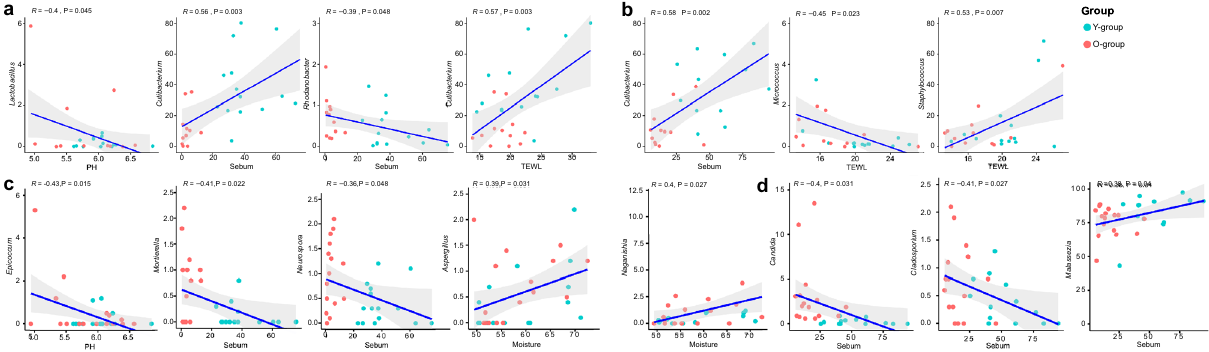
Figure 3. Regression plot for skin metadata and the bacterial and fungal genera with a significant correlation among the top 15 genera in ( a , c ) cheeks and ( b , d ) forehead. For measuring correlation coefficient and P value, Pearson correlation analysis was performed in R. The x-axis represents the value of metadata, and the y-axis corresponds to the relative abundance of the